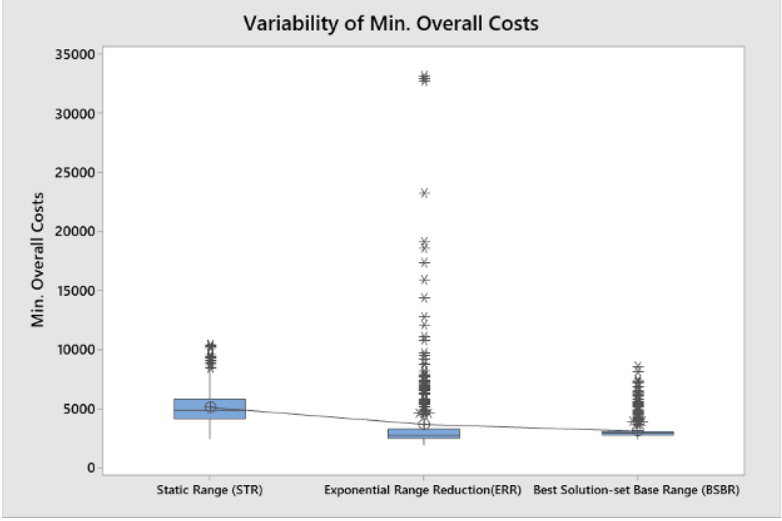
Figure 3. Comparison between the best result obtained in each